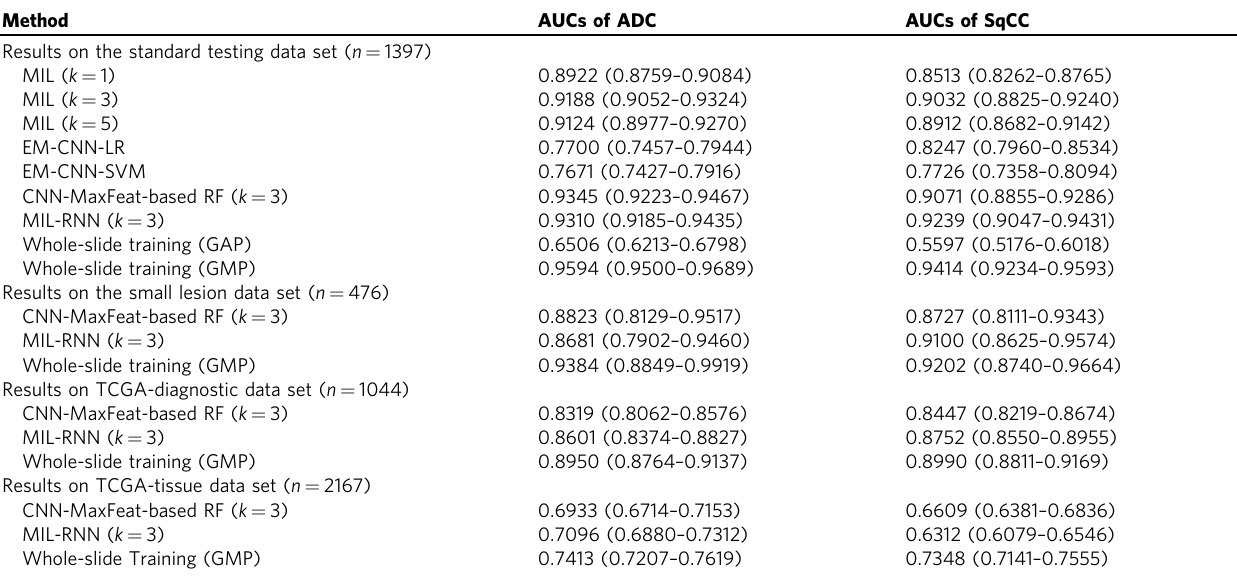
Table 1 Model performances of various MIL methods and our proposed whole-slide training